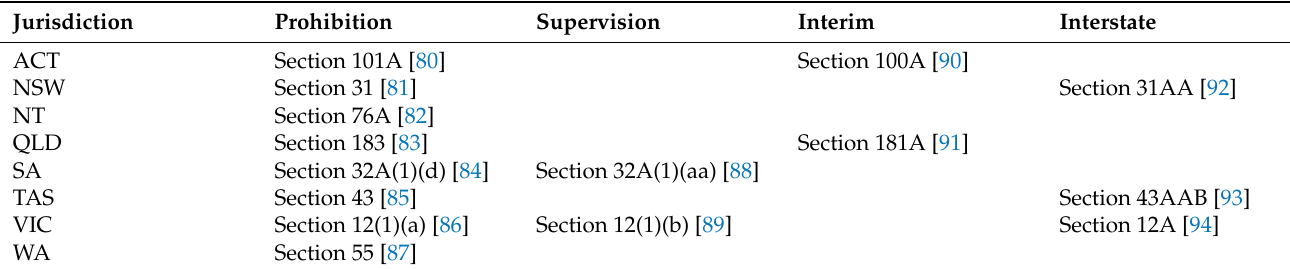
Table 8. Different types of court issued orders outlined in each states and territories’ animal welfare Acts.